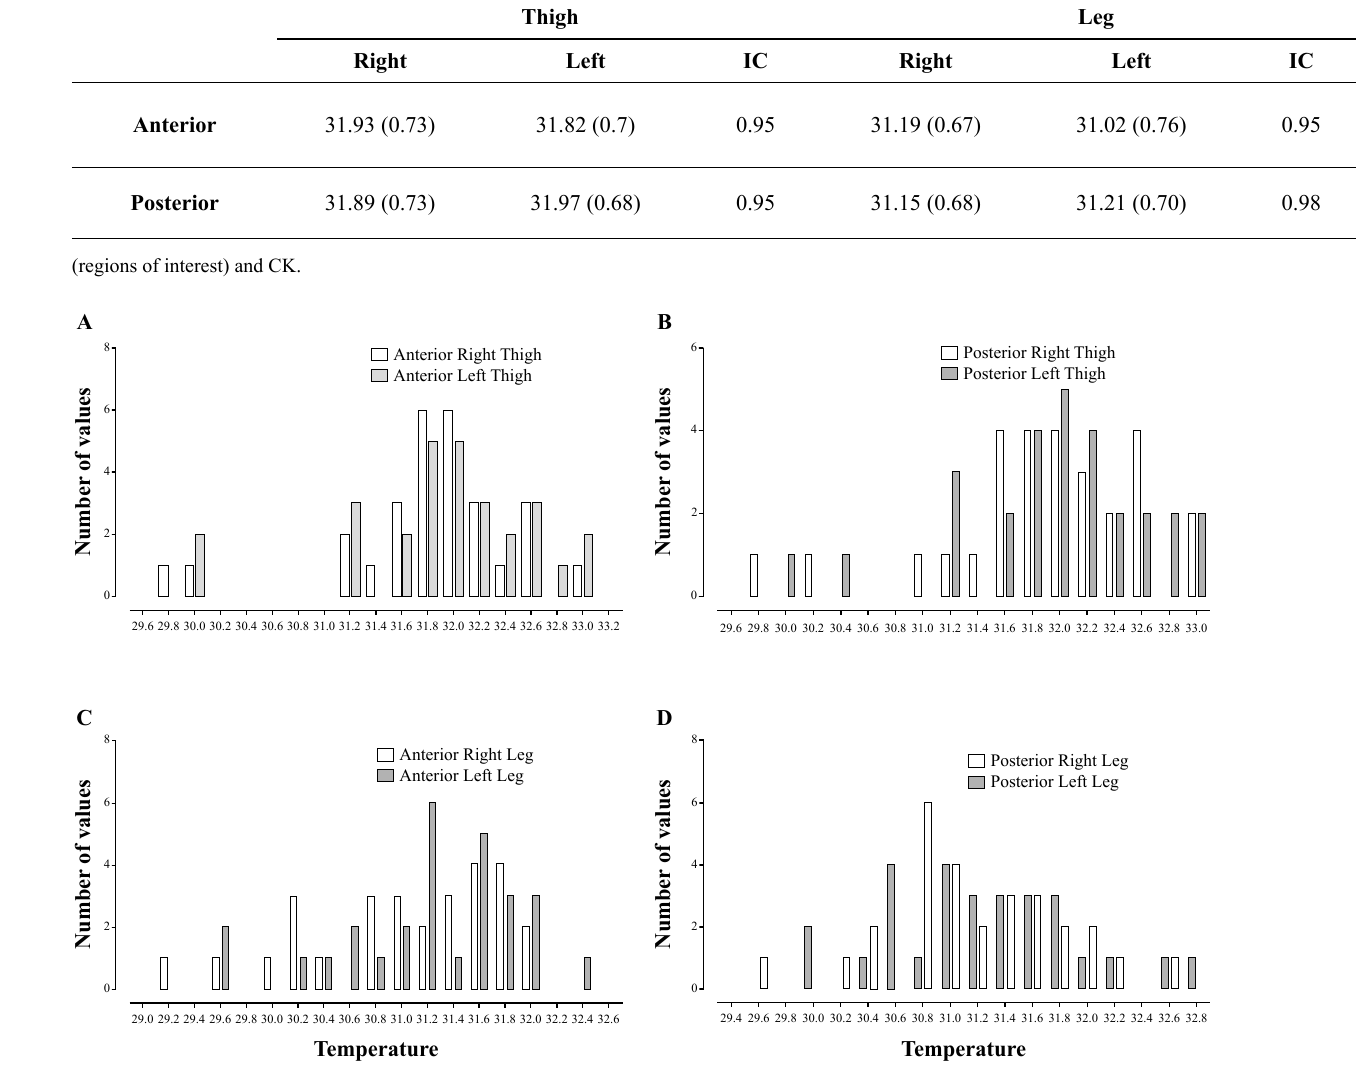
Figure 2. Frequency distribution of the mean values from skin temperature in lower limbs of professional soccer players: A, anterior thigh; B, posterior thigh; C, anterior leg and D, posterior leg.